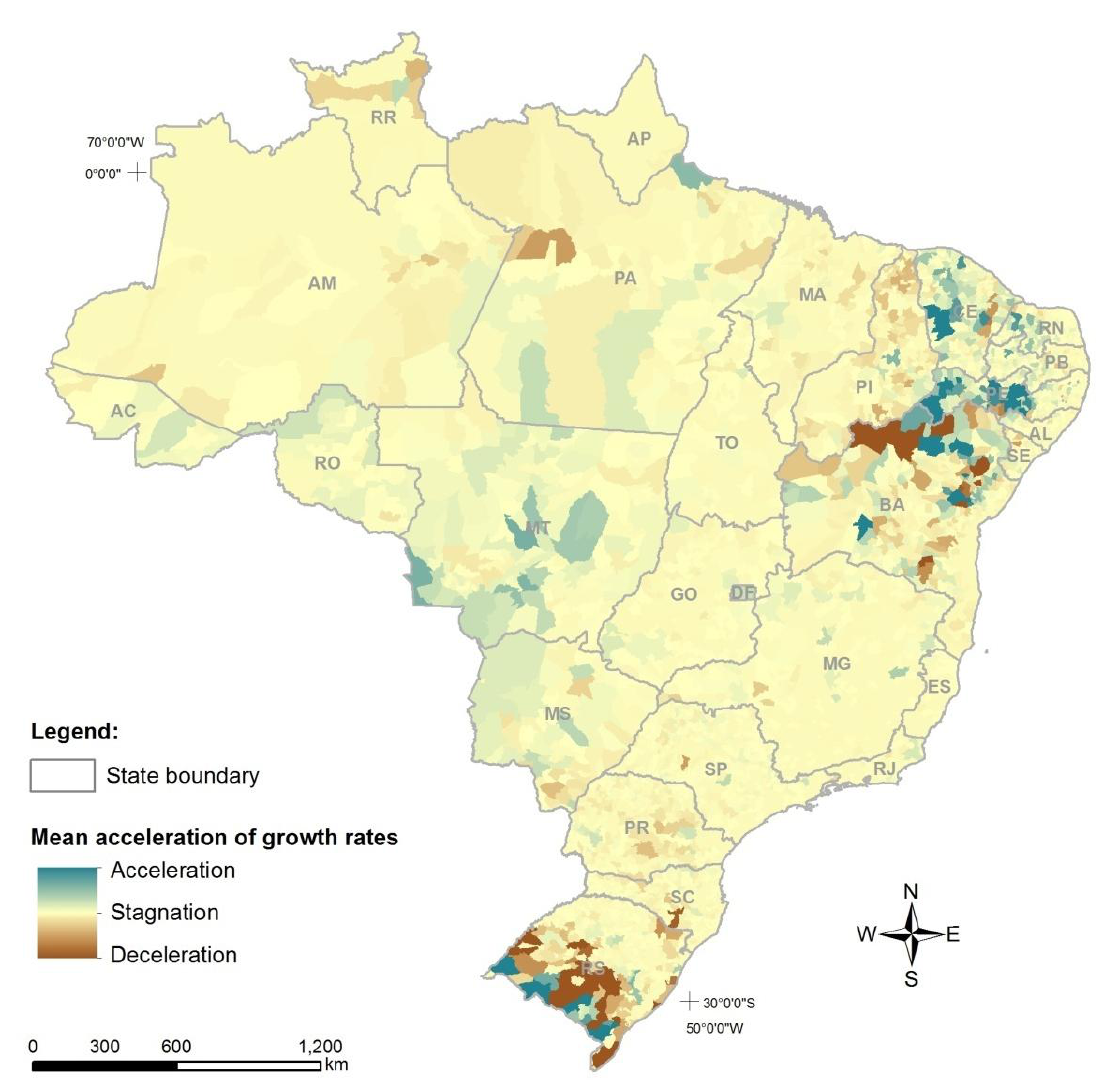
Figure 5. Mean acceleration of growth rates in sheep production in Brazil between 1976 and